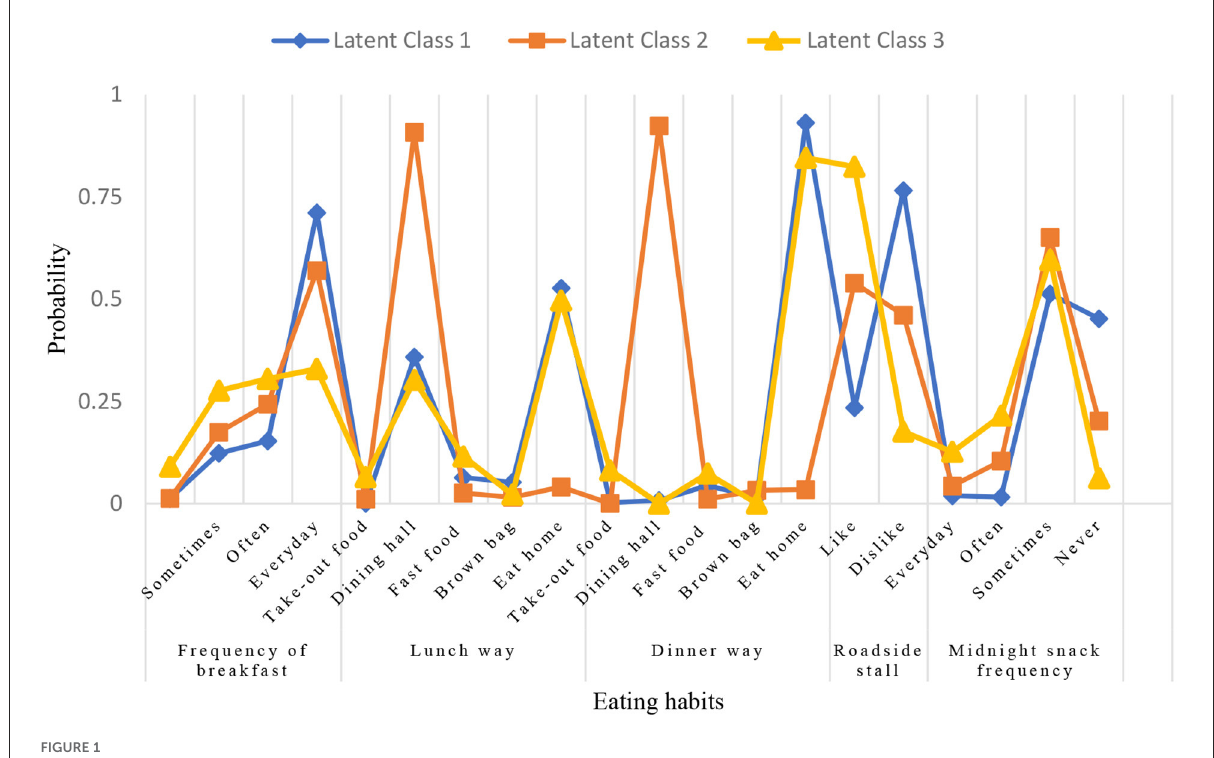
FIGURE1 Conditional item probability plots.